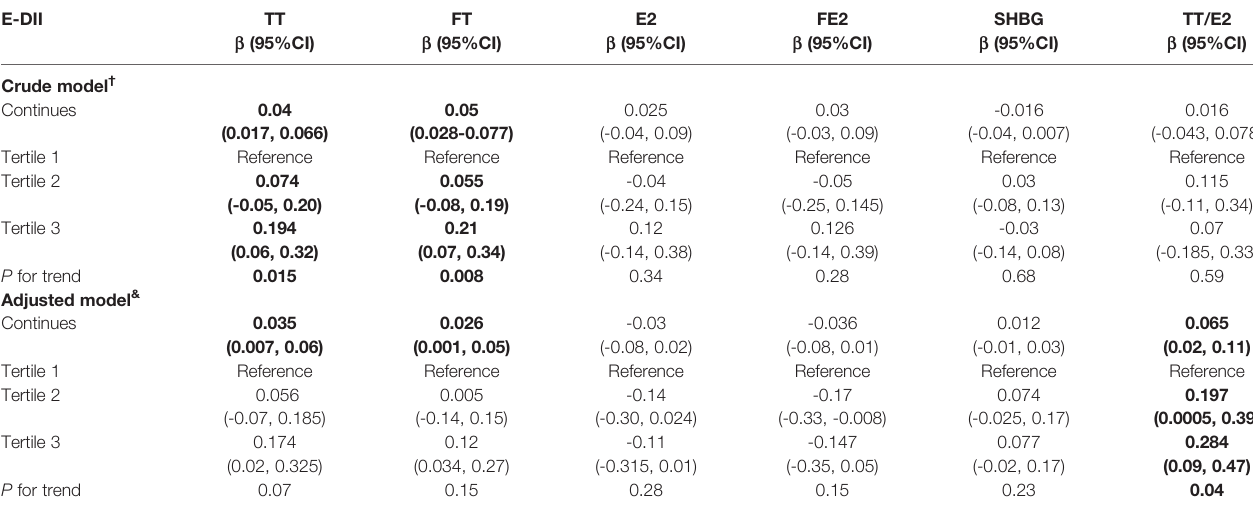
TABLE 2 | Linear association between E-DII and sex